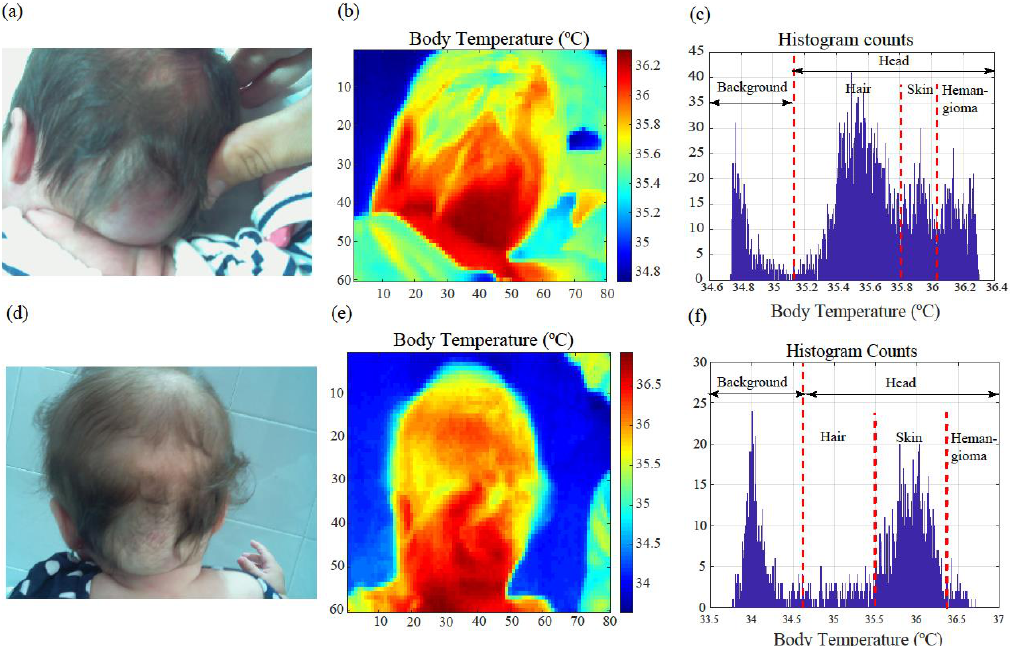
Figure 4. ( a – f ) Study of the temperature of an infantile hemangioma in the occipital region before and after five months of treatment with oral propranolol. The patient was 43 days old at the first consultation. ( a , d ) Images of the hemangioma obtained with a standard digital camera. ( b , e ) Thermo- graphic images of the same hemangioma displaying absolute temperature values. A temperature increment in the hemangioma compared with its surroundings is observed. ( c , f ) Histograms of the thermal images. The histogram modes correspond to the average temperature values in the different scene regions, i.e., image background, hair, skin, and hemangioma.